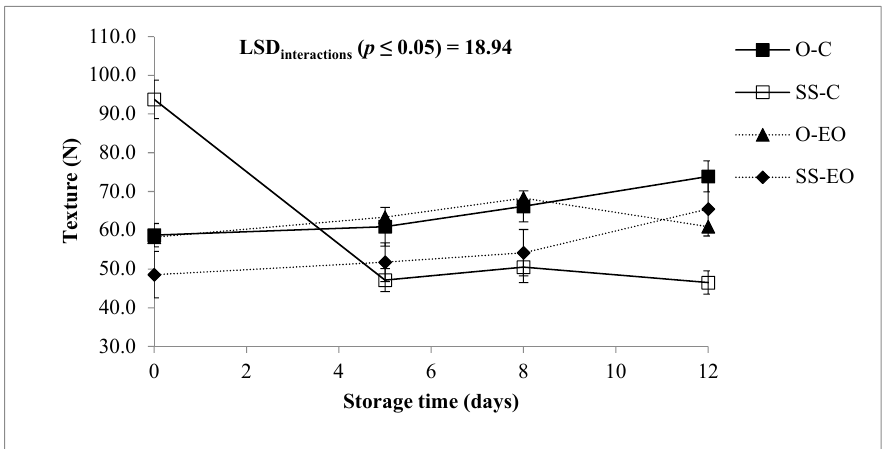
Figure 4. Texture (N) of RTC globe artichoke slices as affected by “genotype × post-harvest treatment × storage time” interaction. O: “Opera F1”; SS: “Spinoso sardo”; C: Control; EO: Samples packed with essential oil of F. vulgare. Data are showed as means ± standard